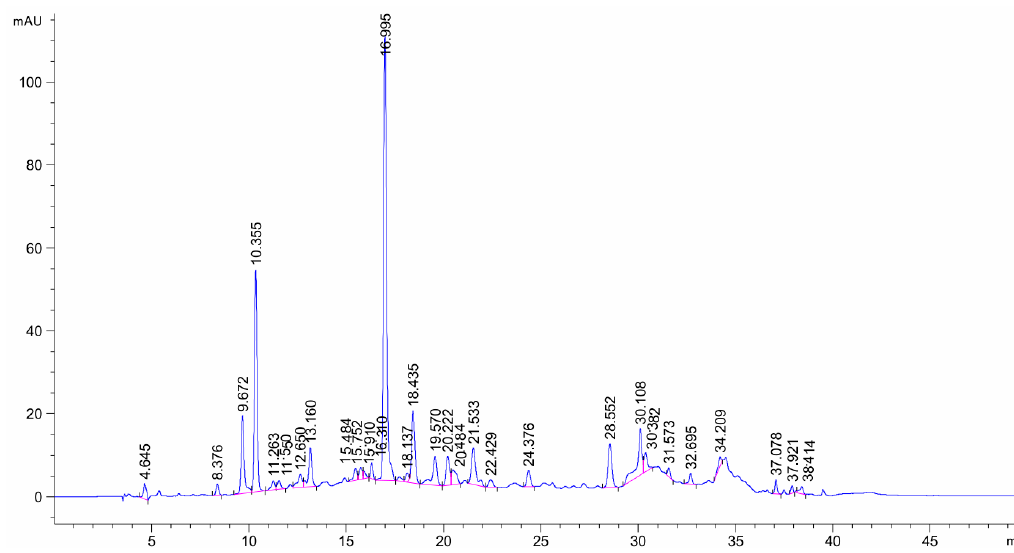
Figure 4. HPLC chromatograms of the EtOAc fraction.